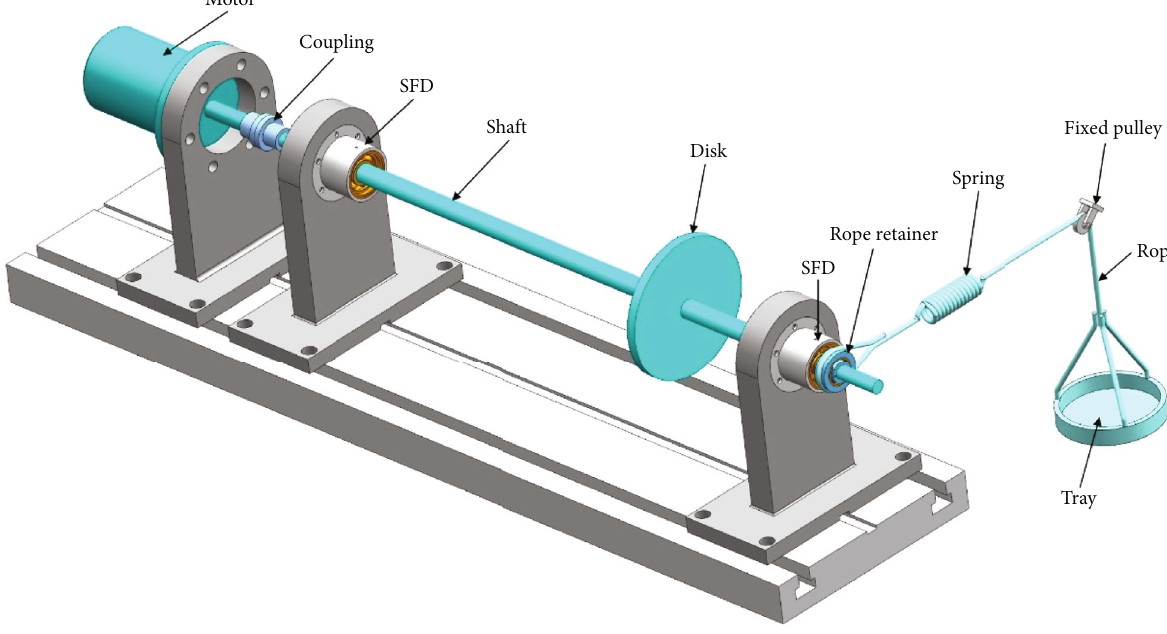
Figure 10: Schematic of the SFD-rotor system with static eccentricity.